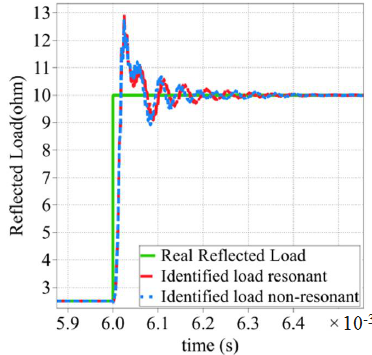
Figure 7. Reflected load identification (Resonant: L p = 300 μH; Non-resonant: L p = 275 μH) [21].